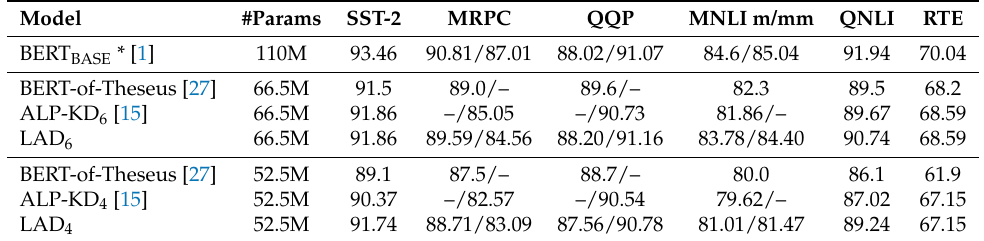
Table 3. Results of six-layer and four-layer student models from the GLUE development sets. Two evaluation metrics with a slash (F1/accuracy scores) are reported for MRPC and QQP, and accuracy scores are reported for the other tasks. Xu et al. [27] averaged the scores of MNLI-m and MNLI-mm. Model